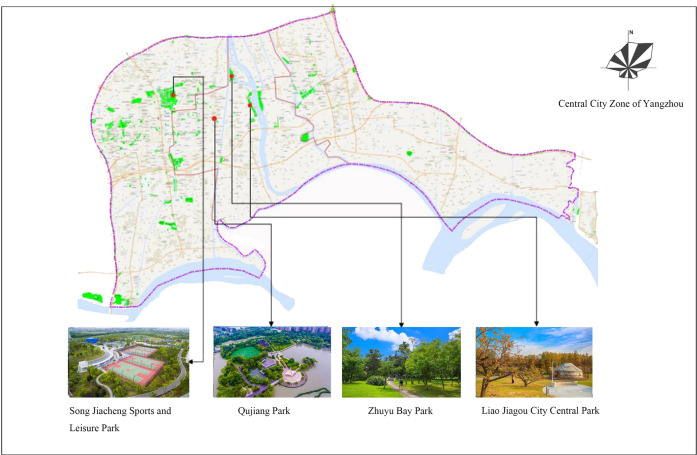
The Location of four typical urban parks in Yangzhou, China.(Reprinted from map data © Open Street Map contributors, map layer by Esri, under a CC BY 4.0 license).